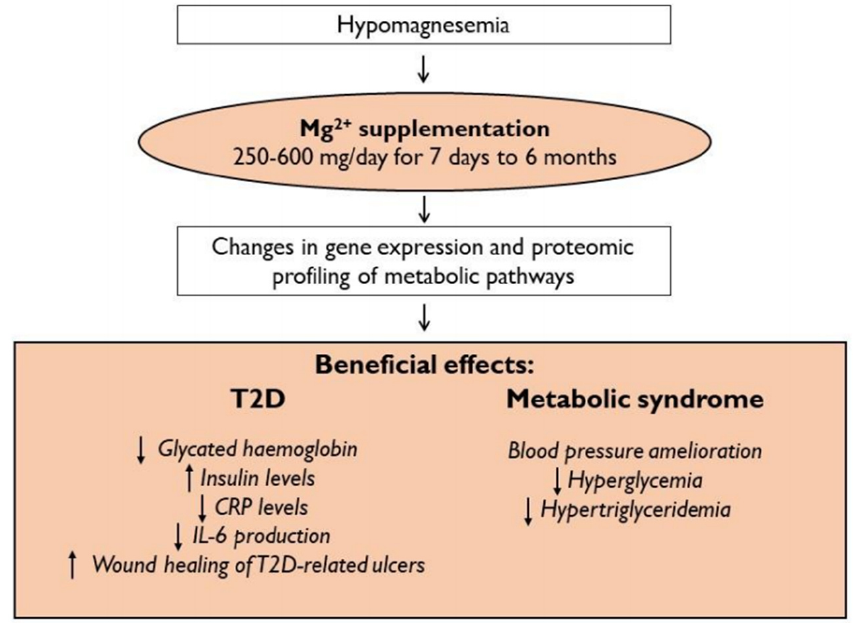
Figure 3. Beneficial effects of magnesium supplementation in hypomagnesemic patients with metabolic syndrome and type 2 diabetes. Table 1. A quick recap of the last and most relevant clinical trials describing the effects of Mg 2+ supplementation on obesity, metabolic syndrome (MetS), and type 2 diabetes (T2D).